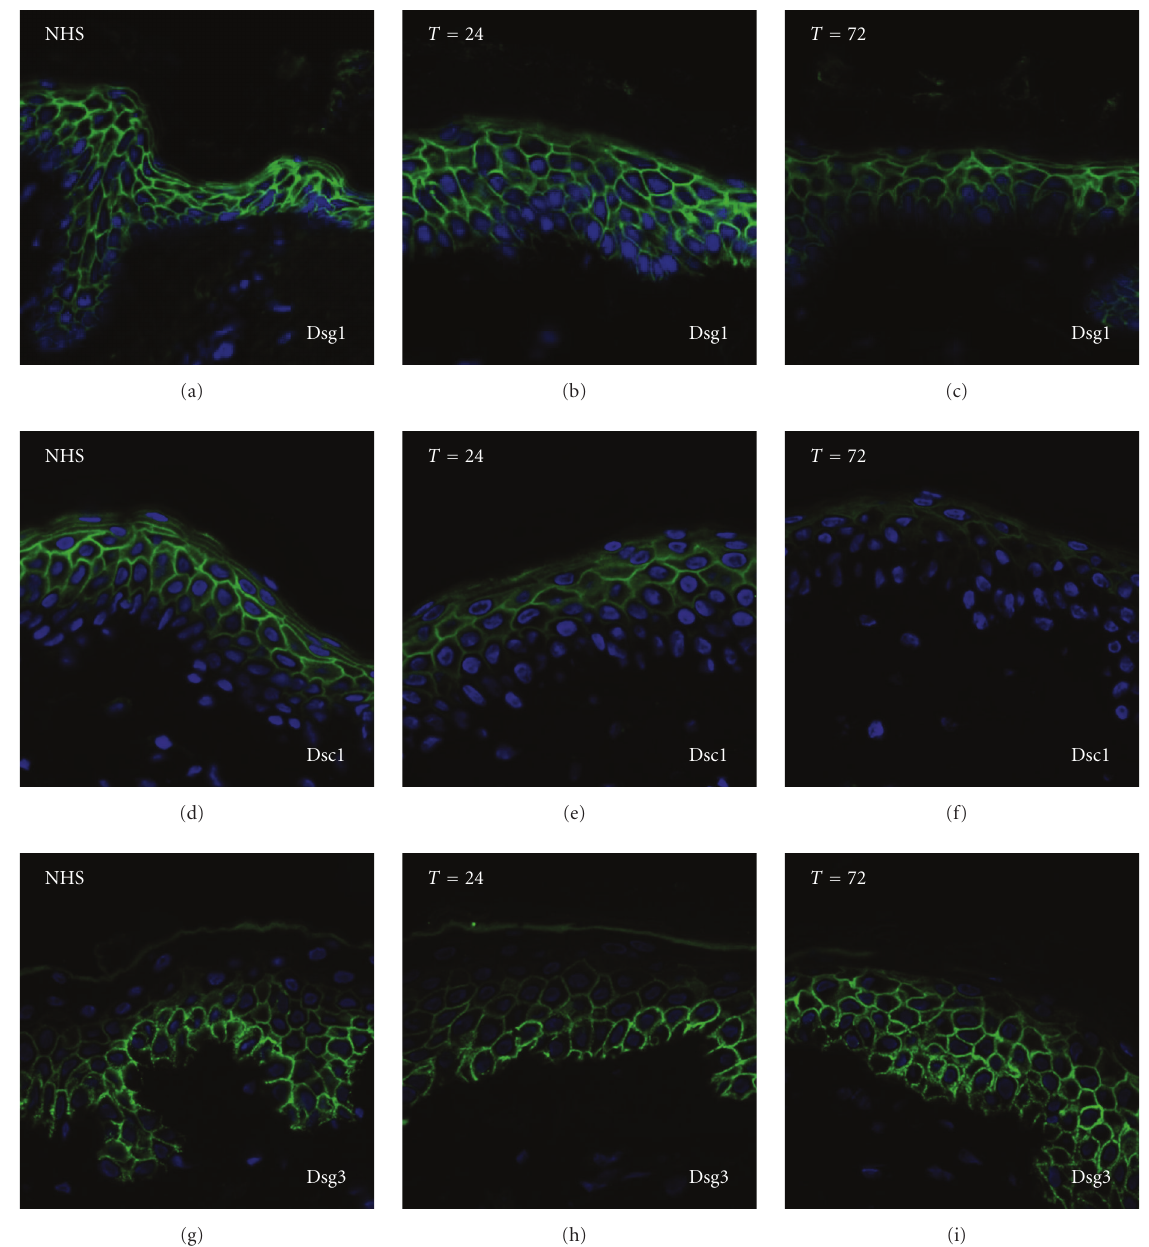
Figure 2: Shift in expression of Dsg1, Dsc1, and Dsg3 in submerged skin cultures after more than 24 hours. (a) Dsg1 is expressed throughout all the layers of NHS. (b) The expression of Dsg1 by skin incubated in medium for 24 hours is comparable to that of NHS. (c) After incubation in medium for 72 hours, Dsg1 expression is reduced. (d) Dsc1 is expressed in the upper layers of the epidermis. (e) The expression of Dsc1 by skin incubated in medium for 24 hours is comparable to that of NHS. (f) After incubation in medium for 72 hours, Dsc1 expression is reduced. (g) Dsg3 is expressed in the basal and suprabasal layers of the epidermis in NHS. (h) The expression of Dsg3 after incubation in medium for 24 hours is comparable to that of NHS. (i) After incubation in medium for 72 hours, Dsg3 is also expressed in the upper layers of the